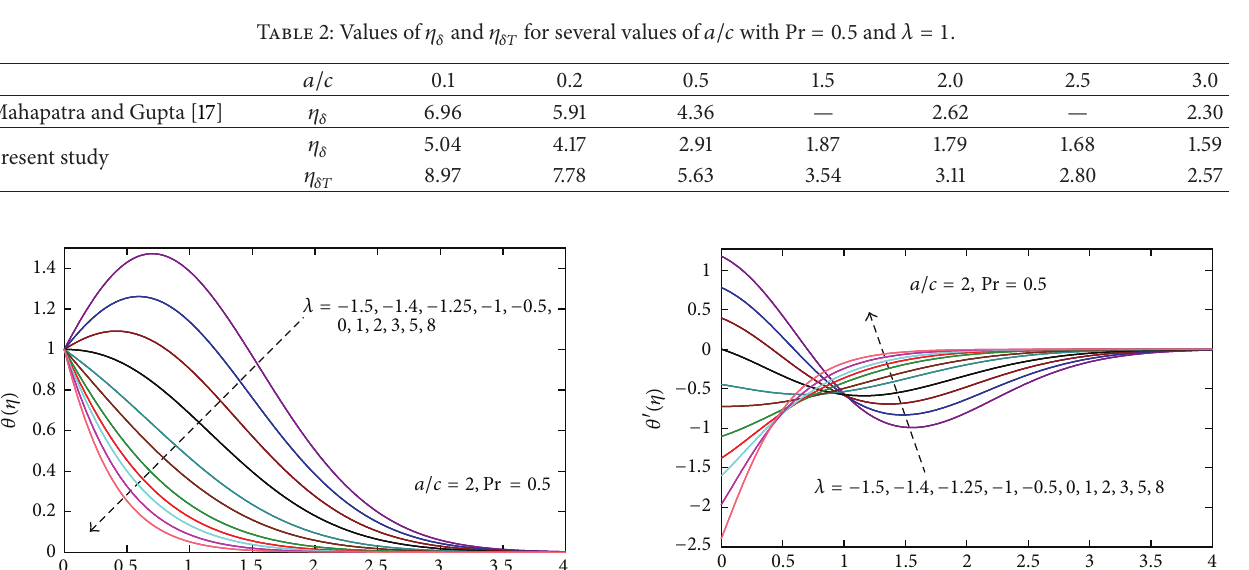
stagnation point flow over a linearly stretching sheet which is obtained by Mahapatra and Gupta [17]. In exponential